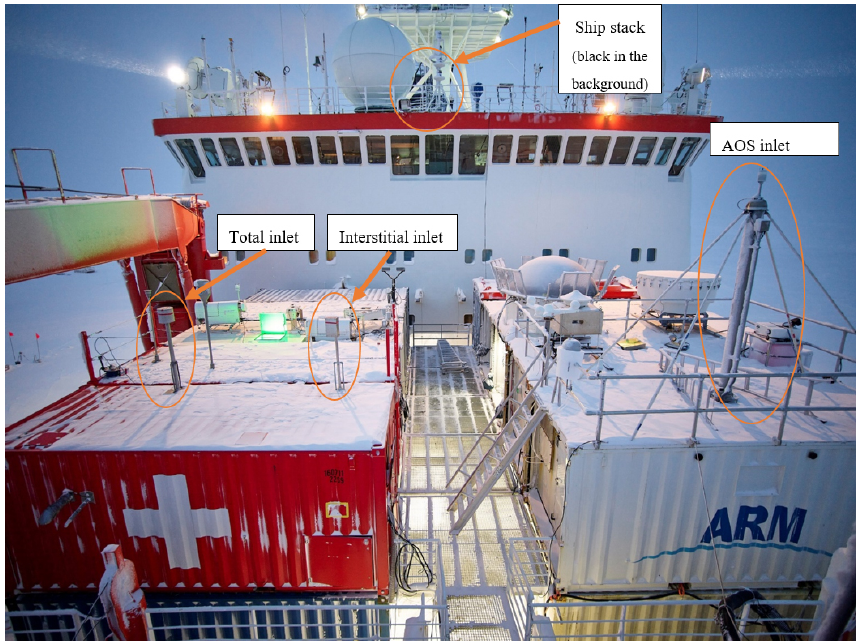
Figure A2. Bow of the ship during the expedition. In red with a white cross, the Swiss Container with its two inlets. The ARM measurements were performed on the port side of the ship in the white container at the front with a higher inlet. Photo credit: Michael Gutsche.